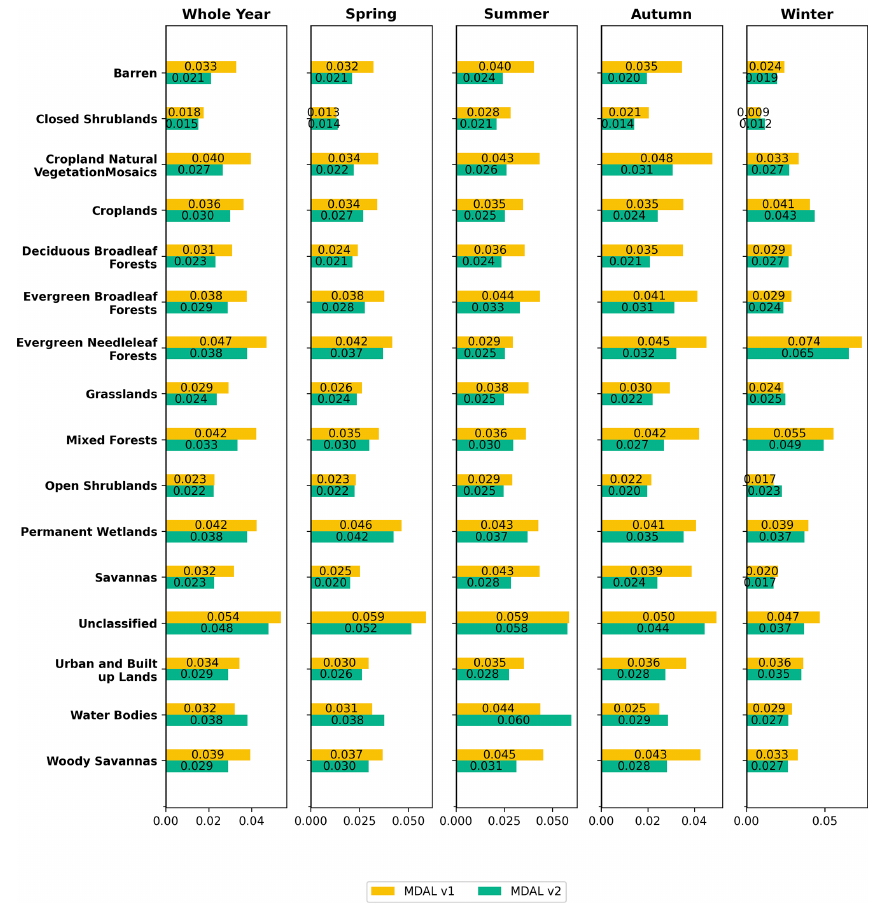
Figure 11. Mean MAE with regard to ETAL by land cover and season. For all pixels the “true” season was taken into account, depending on whether the pixel is located in the Northern or Southern